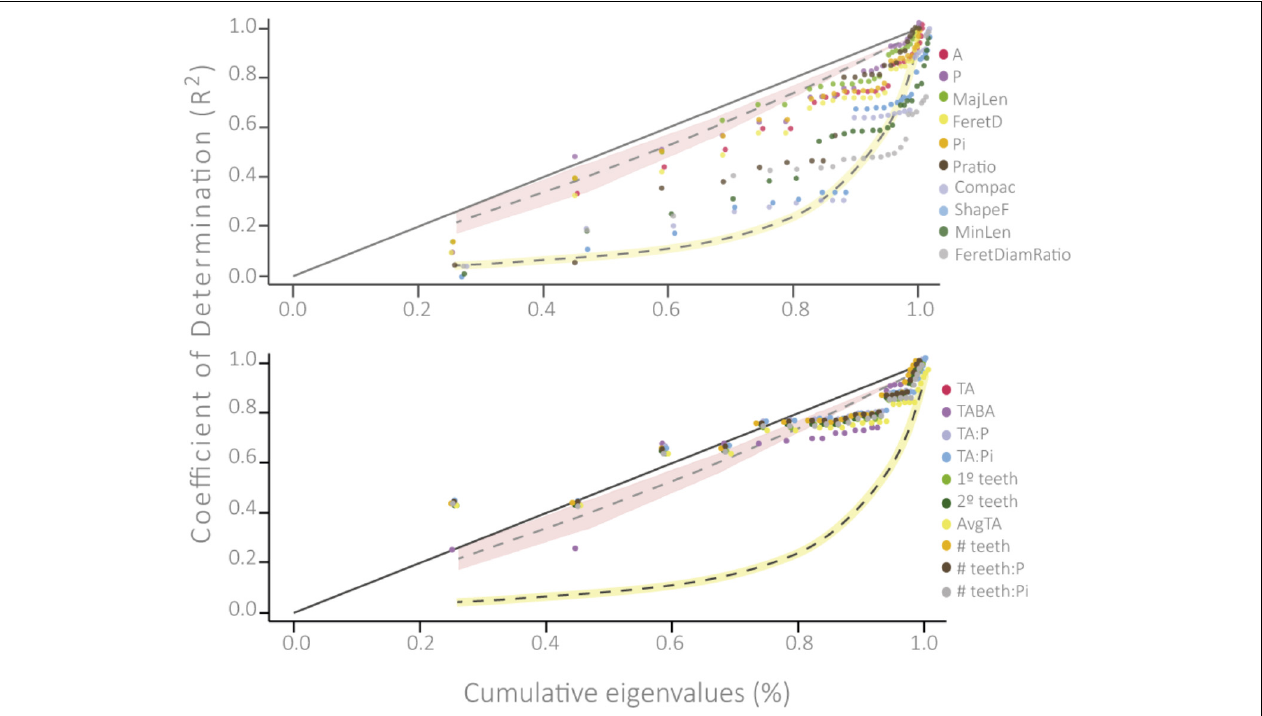
FIGURE 4 | Phylogenetic Signal Representation curve (PSR) for the 10 leaf traits evaluated in this work. The yellow curve represents the White Noise null model of evolution and the pink area below the 45 ◦ line represents the Brownian motion neutral model of evolution. Above: PSR curve for traits associated to size and shape of the leaf. Below: PSR curve for traits associated to leaf teeth (please see description of each physiognomic variable in Table 1